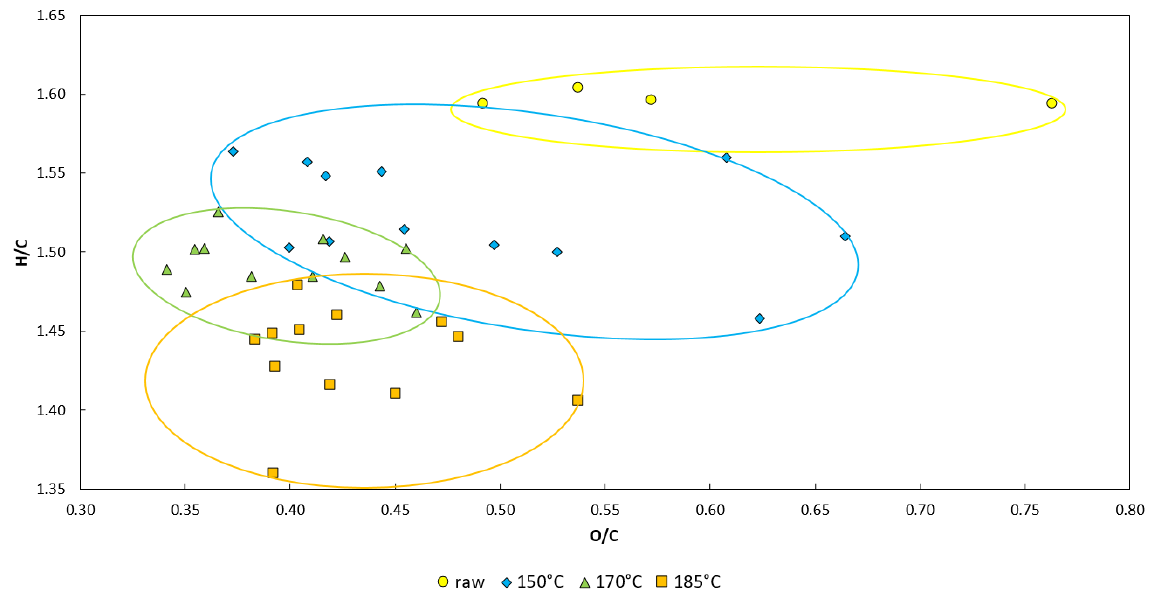
Figure 1. van Krevelen diagram with O/C and H/C ratios for all single measurements of raw organic fractions of municipal solid waste (OFMSW) and hydrothermally treated variants (biochars). The ellipses were estimated and inserted for illustrational purposes.